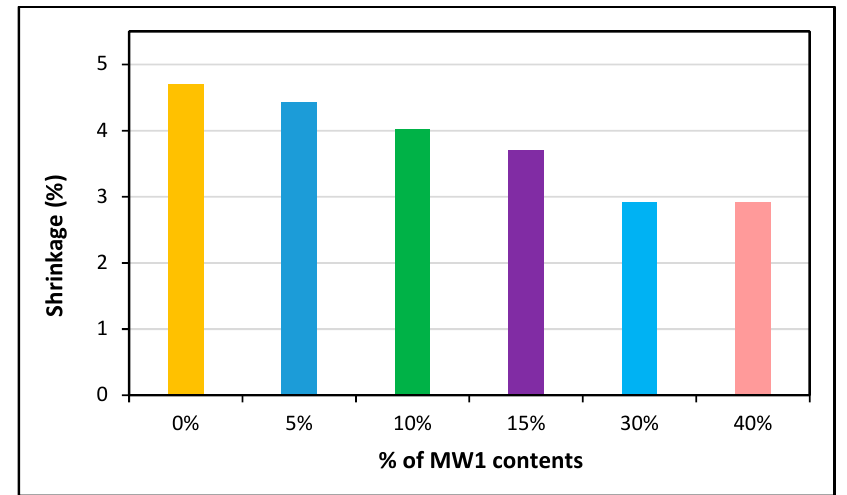
Figure 13. Reduction in elastic modulus at various temperatures and various industrial waste contents [234].